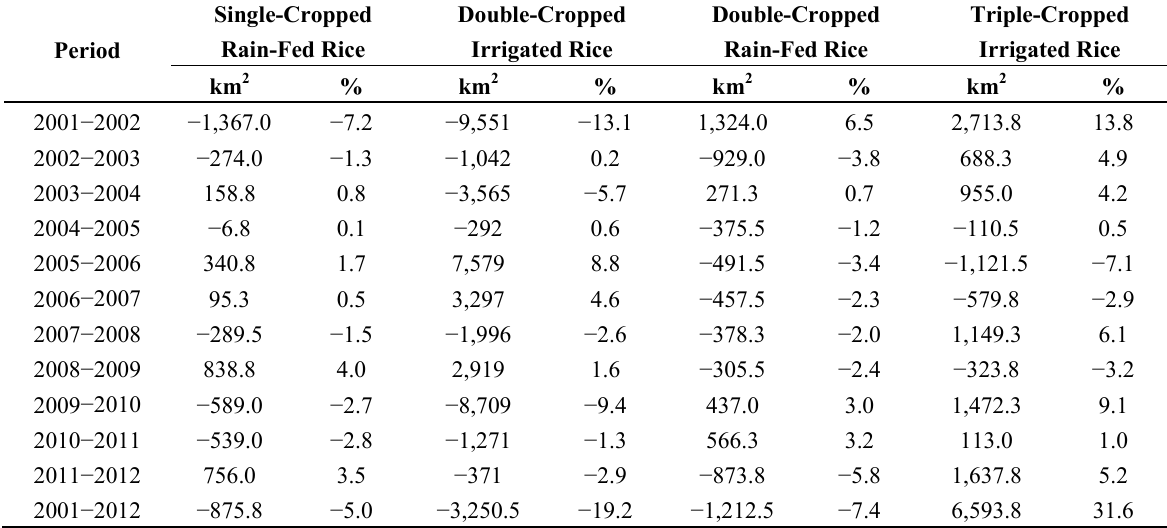
Table 4. Changes in harvesting area derived from MODIS-based classification results for rice cropping systems for every year period during 2001 −